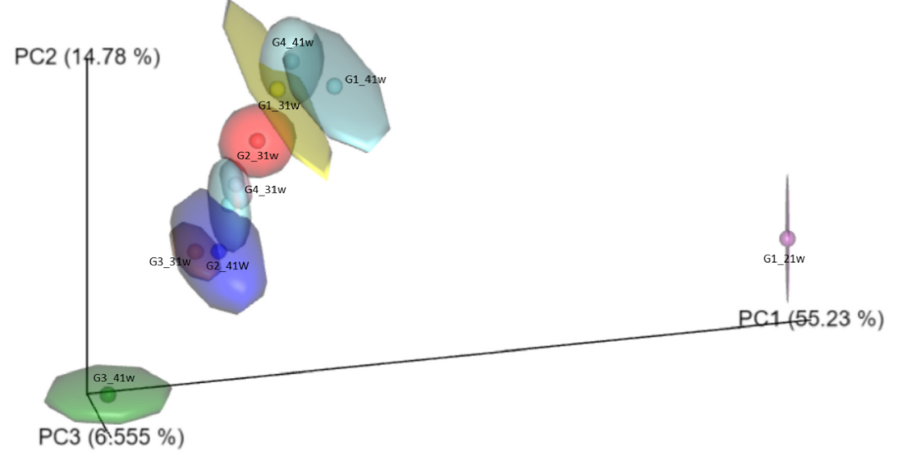
Figure 2. Beta diversity calculated for bacterial communities associated with fecal samples obtained from laying hens supplemented and unsuplemented with an Allium -based phytobiotic, and chal- lenged or unchallenged against Salmonella Pullorum. G1: Control group; G2: Salmonella -phytobiotic- supplemented unchallenged hens; G3: Salmonella -phytobiotic-supplemented challenged hens; G4: Salmonella -challenged hens. Samples were obtained from hens at 21, 31, and 41 weeks of age (21 w, 31 w, and 41 w, respectively). The number of hens for each treatment was 48. Microorganisms 2022 , 10 , x FOR PEER REVIEW Regarding the functional profile of bacterial communities, 147 METACYC pathways were predicted, including all samples. At the level of the functional category, pathways related to the degradation of aromatic compounds, carbohydrate biosynthesis, carbohy- drate degradation, and amino acid metabolism were observed. The most representative pathways based on relative frequency in G1 at 21-w corresponded to genes involved in syringate, protocatechuate, catechol, nicotinate, vanillin, vanillate, L-arginine, and L-orni- thine degradation. A remarkable metabolic change was predicted at week 41, mainly de- fined by polyamine biosynthesis and pyrimidine ribonucleosides degradation, as we ob- served in G1 at 41 w. Moreover, in the G2-41w sample, genes involved in degradation pathways of some compounds such as chlorosalicylate and L-rhamnose were identified, as well as genes related to the biosynthesis of archaetidylinositol and sucrose; whilst, in the sample corresponding to G3 at 41 w, nitrobenzoate, L-tryptophan, toluene, catechol, and methylcatechol degradation pathways were mostly registered. Finally, in samples corresponding to G4 at 41 w, genes involved with the aerobactin biosynthesis were pre- dicted (Figure 3).